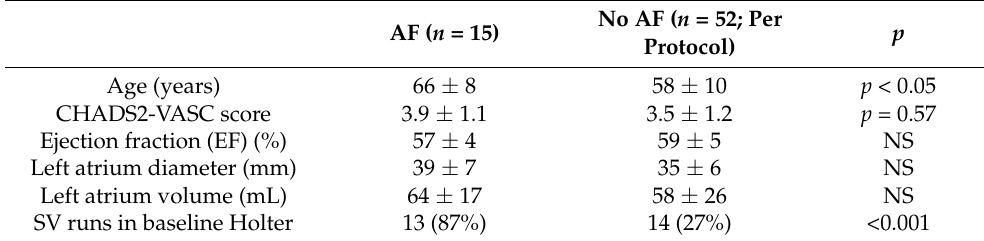
Table 5. Patients with vs. without atrial fibrillation—clinical and echo parameters.